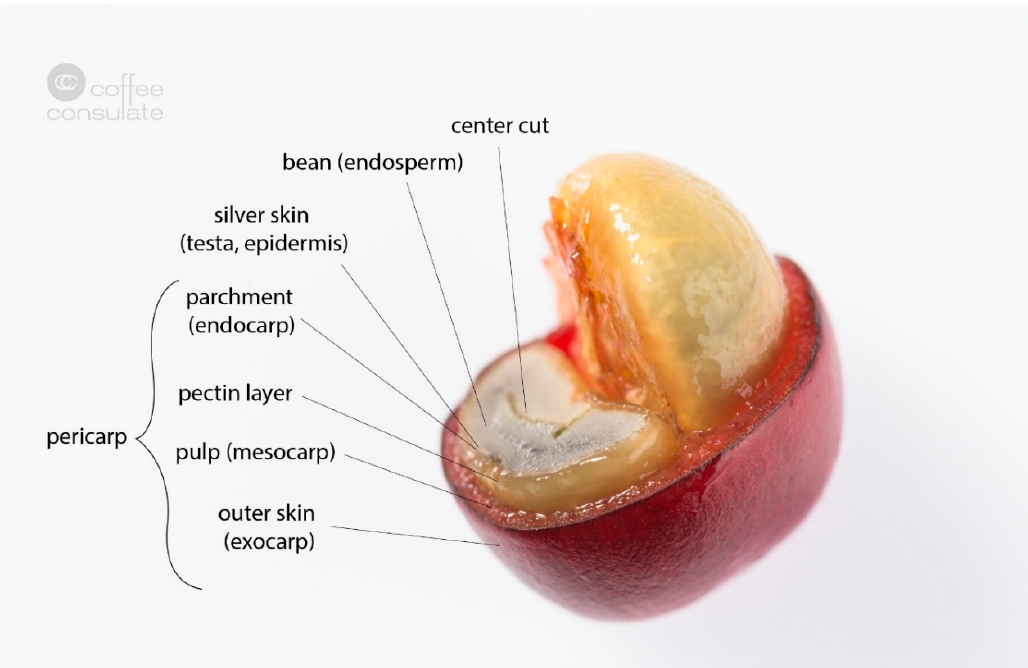
Figure 2. Cross section of a coffee cherry with its different layers.